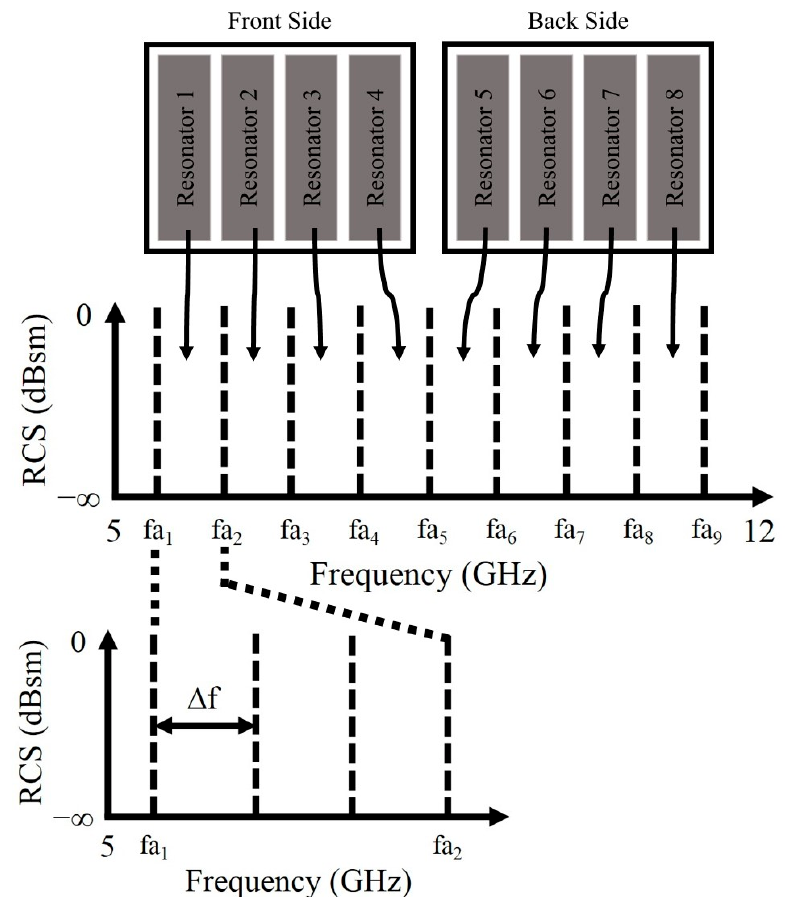
Figure 14. Frequency shift coding (FSC) technique to enhance capacity of the proposed chipless RFID tag.